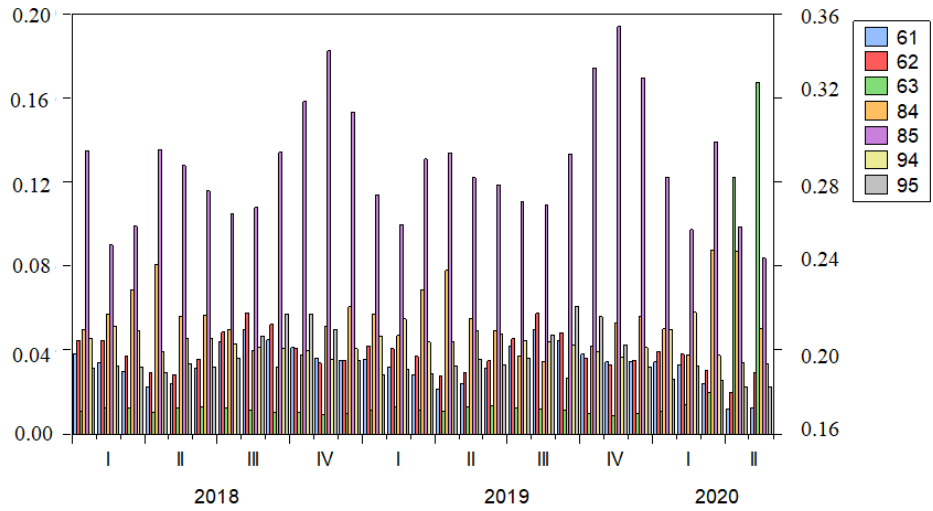
Figure 3. E.U. import shares of the selected articles by year. Source: own investigation.